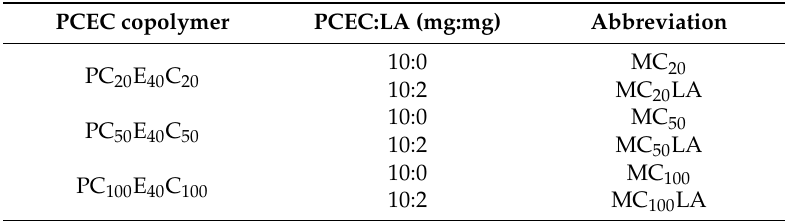
Table 1. Preparation of blank nano-sized micelles and lauric acid (LA)-loaded micelles with different polymer to LA ratios. The copolymer name subscript indicates 1/100 of the designed molecular weights of each